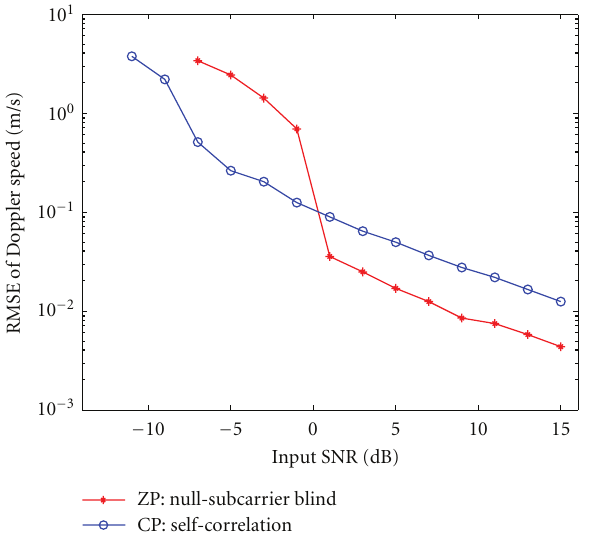
Figure 6: Null-subcarrier-based method in ZP-OFDM and CP- OFDM.